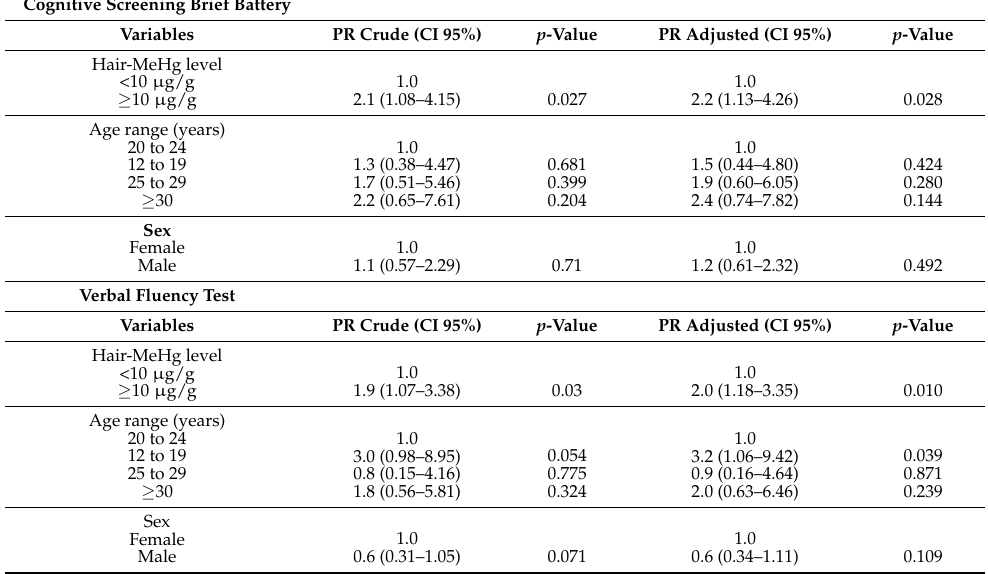
Table 4. Logistic regression model (crude and adjusted) of prevalence ratios (PR) in the Brief Cognitive Screening Battery (BCSB) and verbal fluency test, Sawr é Muybu Indigenous Land, Par á state, Brazilian Amazon,